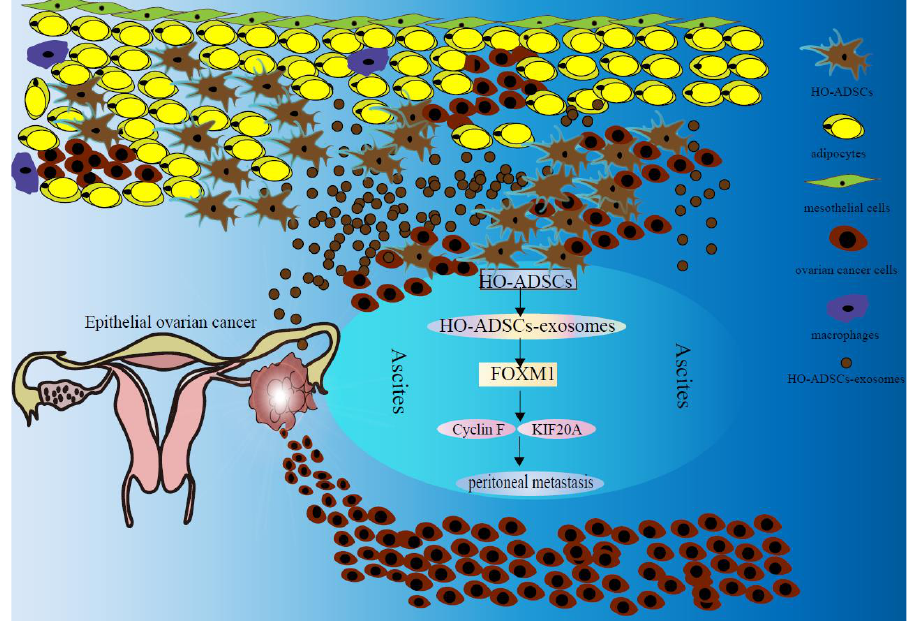
Figure 10. Schematic diagram shows the mechanism underlying HO-ADSC exosomes being se- creted into ascites and their role in ovarian cancer growth and metastasis. into ascites and their role in ovarian cancer growth and